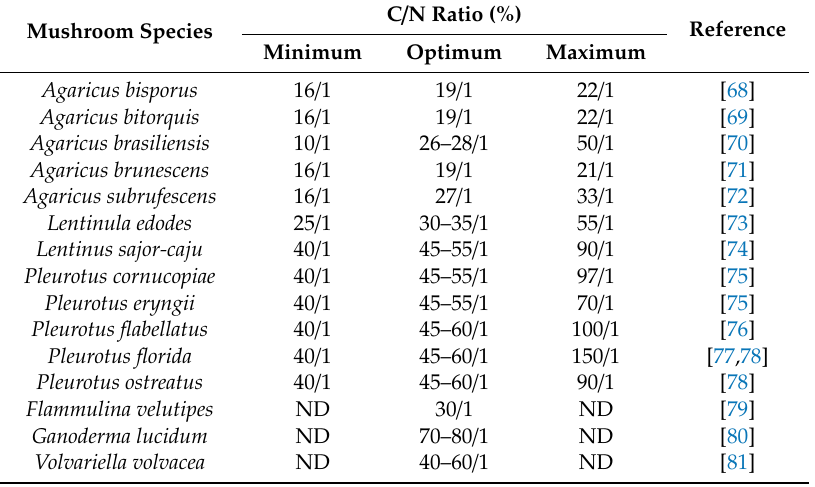
Table 2. The carbon / nitrogen ratio in substrate to obtain the highest yield of some mushroom species. Mushroom